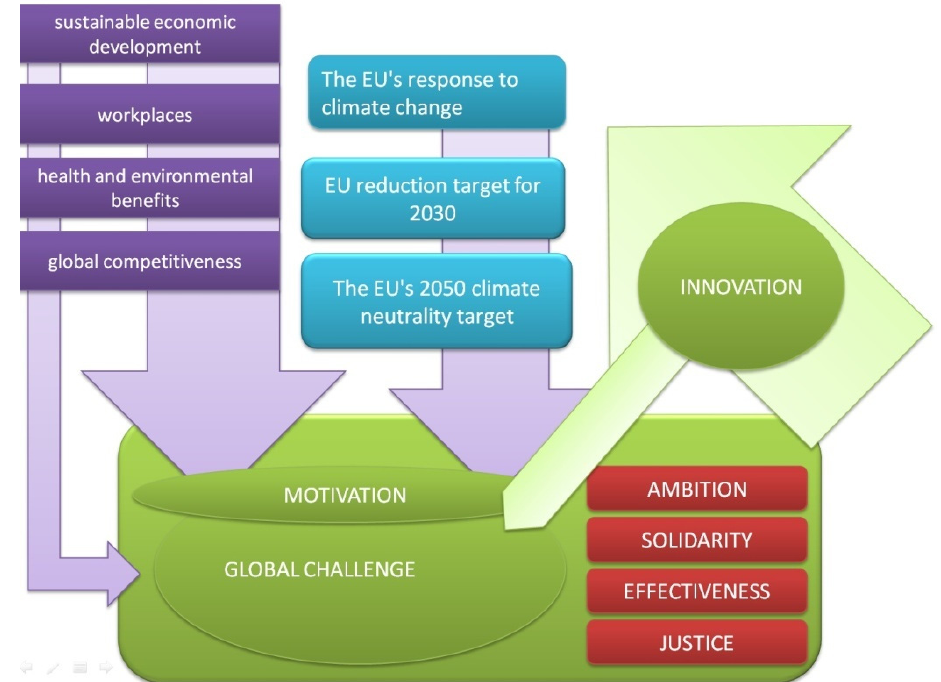
Figure 29. Global challenge assuming innovation and motivation [70,71].